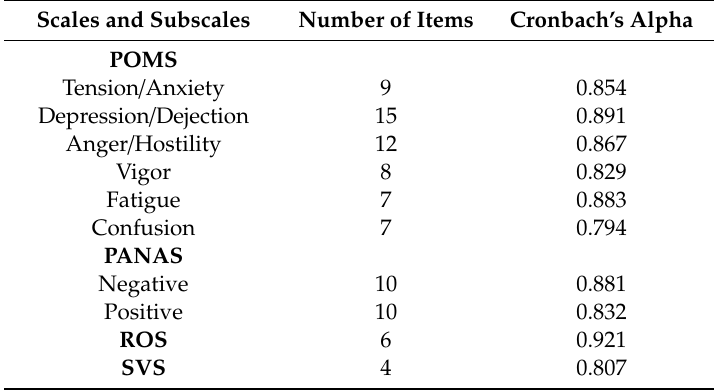
Table 1. Verification of internal consistency and number of items for each (sub)scale.